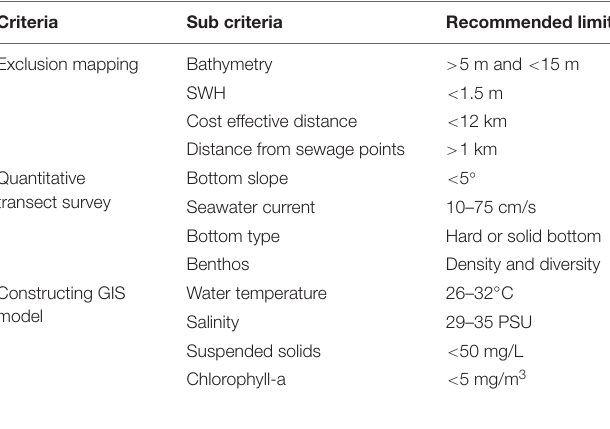
TABLE 2 | Description of criteria and sub-criteria for artificial reef deployment (adapted and modified from Barber et al., 2009; Kapetsky et al., 2013; Mousavi et al., 2015; Jha et al.,